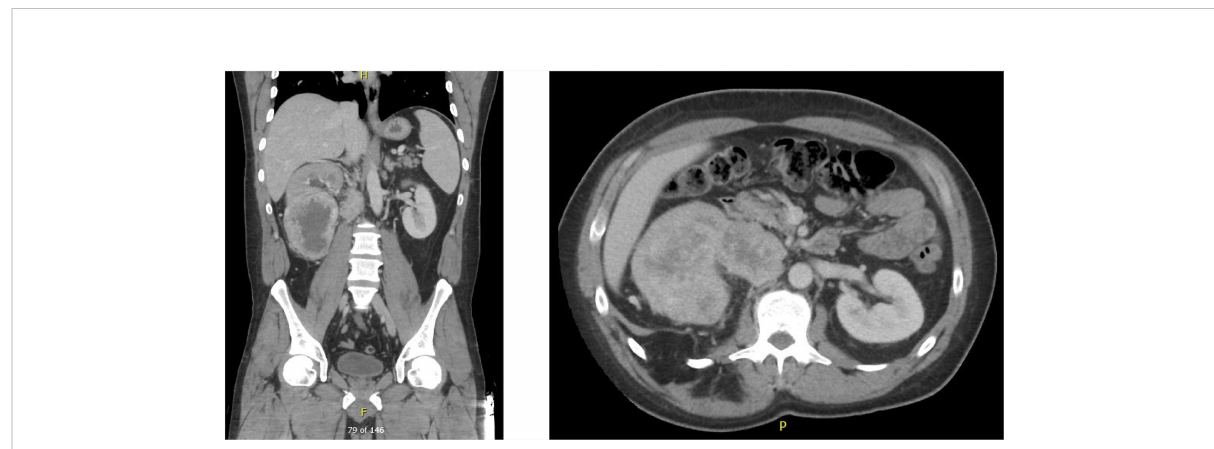
FIGURE 1 Pre-nephrectomy CT showing multiple right renal masses with tumor thrombus extending into the right renal vein and around the